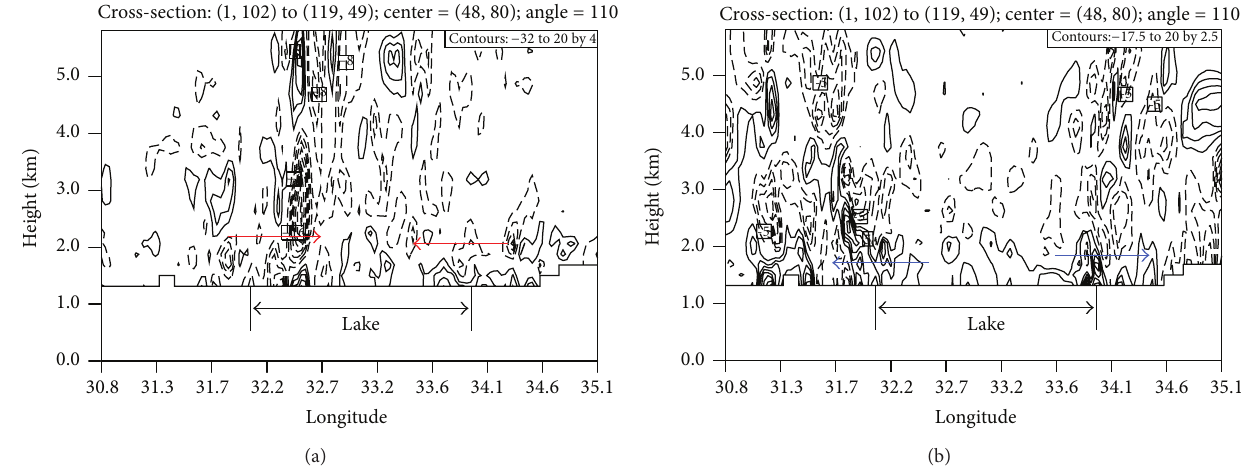
Figure 13: Cross-sections of divergence flow (10 −5 m −1 ) along the two-rainfall maxima at (a) 0600 LST and (b) 1500LST.